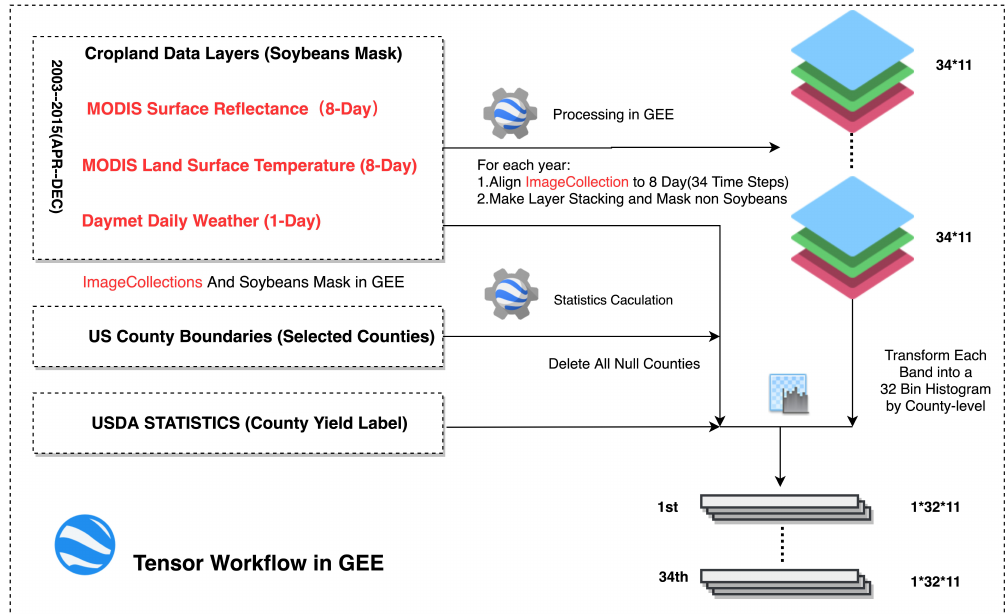
Figure 2. GEE-based tensor